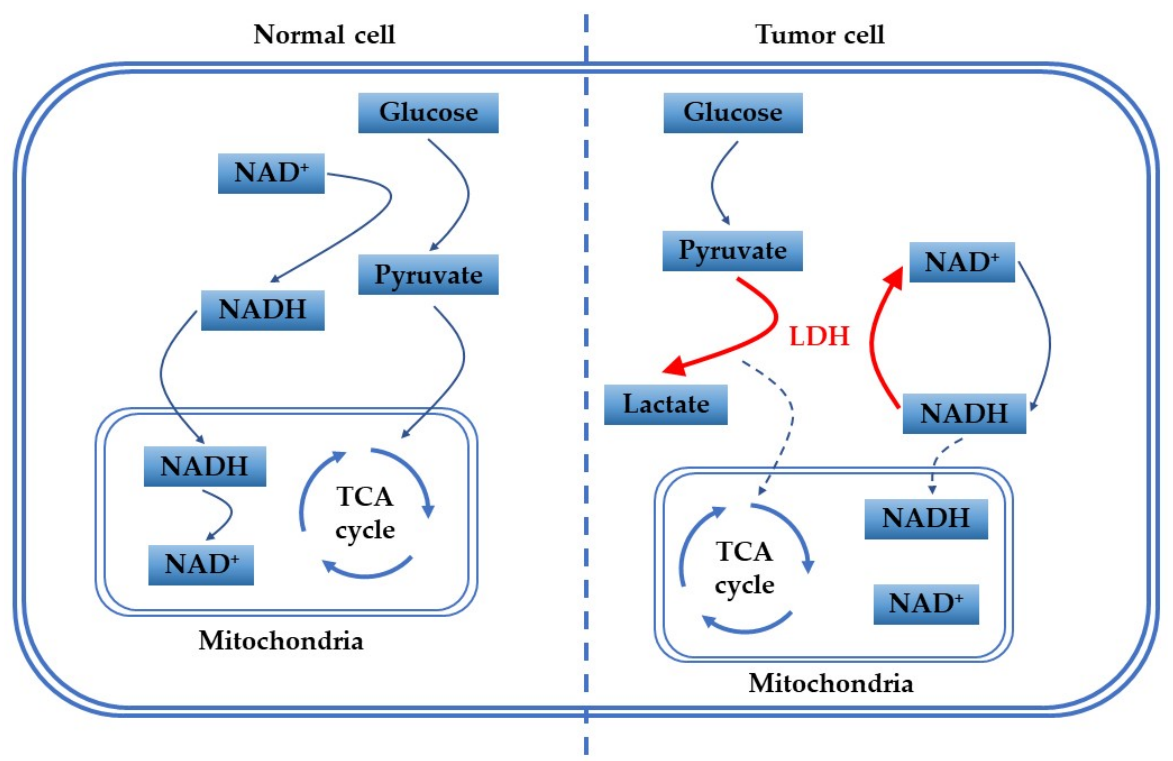
Figure 1. Difference of glucose metabolism between normal and tumor cells in vivo.